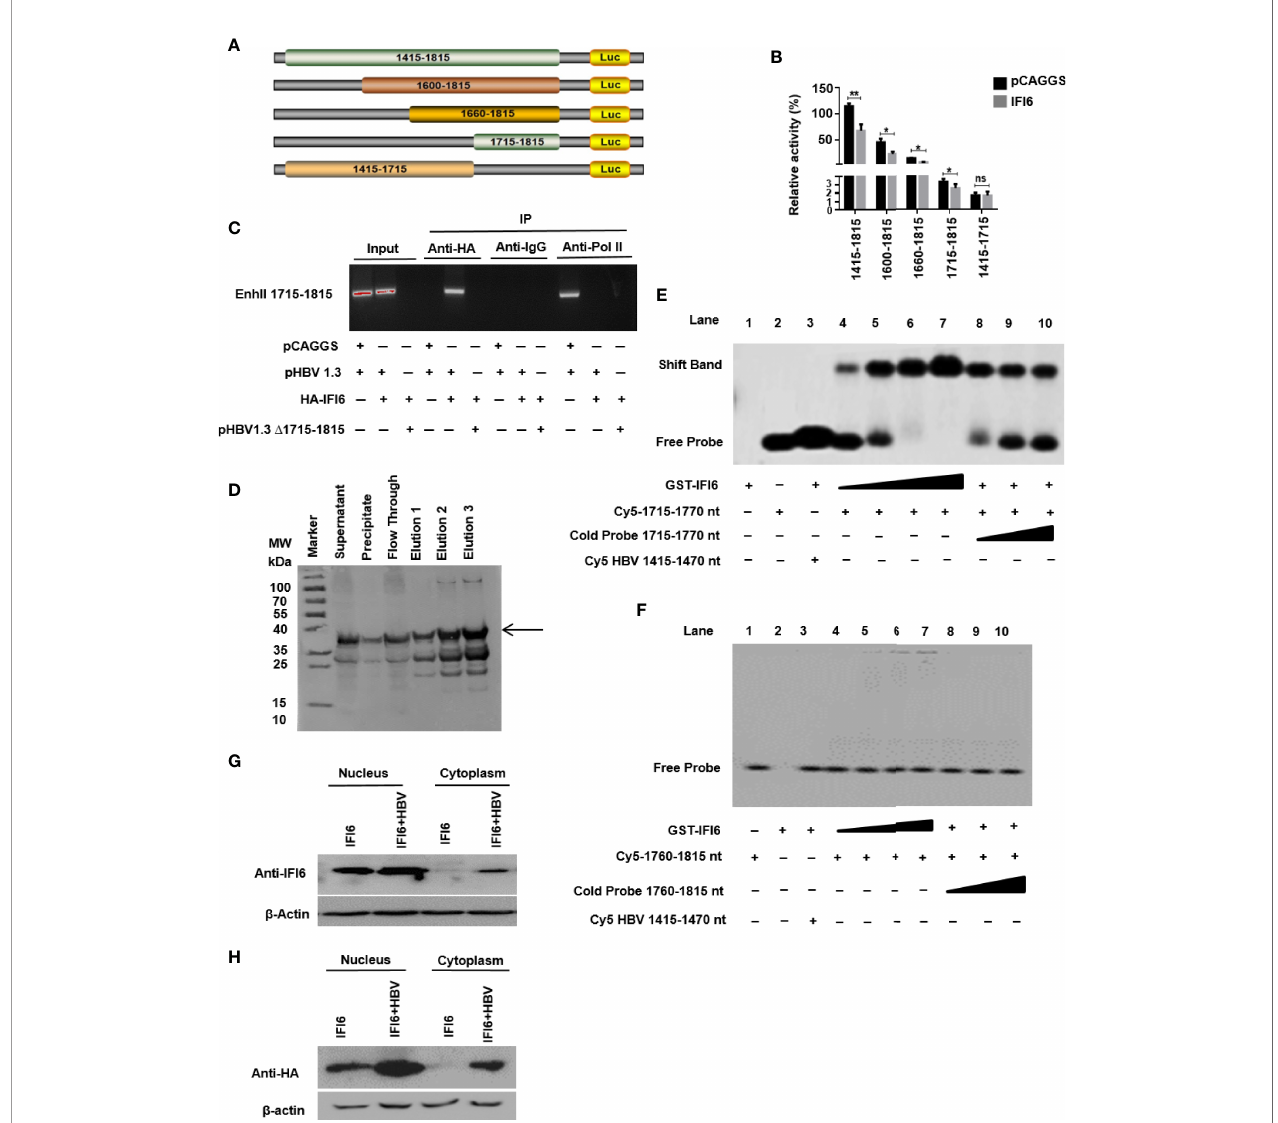
FIGURE 5 | IFI6 suppresses HBV replication by binding to 1715-1770 nt of EnhII/Cp promoter. (A) Schematic diagram of EnhII/Cp promoters and its truncated mutants. (B) The mutants were subcloned into pGL3 basic plasmid and transfected in HepG2 cells. Cells were harvested after 48 h of transfection, and Dual- luciferase activity was measured. (C) HepG2 cells were seeded in a 10 cm dish and transfected with pHBV1.3 (5 µg) with IFI6 (5 µg) or control plasmid (pCAGGS, 5 µg), after 48 hours of transfection, cells were harvested, immunoprecipitate was extracted with overnight incubation of Anti-Polymerase II, mouse IgG, and Anti- HA-Tag antibody to analyze the binding ability of EnhII 1715-1815. The protein-bound EnhII 1715-1815 DNA was extracted, ampli fi ed with PCR, and detected with agarose gel electrophoresis. (D) Expression and puri fi cation of recombinant GST-IFI6 protein were performed from E.coli . The western blot was performed to measure the size of the GST-tagged IFI6 protein. The arrow indicated the expected band size of protein, and elution 3 was used for subsequent EMSA experiments. (E) EMSA was performed to determine the speci fi c binding of IFI6 with EnhII/Cp 1715-1770 region. Lane 1, GST IFI6 protein alone, Lane 2, Cy5 labeled probe (1715-1770 nt) alone, Lane 3, Cy5 labeled probe (1715-1770 nt) incubated with non-speci fi c competitor probe (Cy5 1415-1470), Lane 4-7, Cy5 labeled probe (1715-1770 nt) incubated with different concentrations of GST IFI6 protein, Lane 8-10, a competition of Cy5 labeled probe (1715-1770 nt) with different concentrations of an unlabeled cold probe (1715-1770 nt). (F) EMSA was used to determine the binding of IFI6 with EnhII/Cp 1760-1815 region. Lane 1, Cy5 labeled probe (1760-1815) alone, Lane 2, GST IFI6 protein alone, Lane 3, Cy5 labeled probe (1760-1815 nt) incubated with non-speci fi c competitor probe (Cy5 1415-1470), Lane 4-7, Cy5 labeled probe (1760-1815 nt) incubated with different concentrations of GST IFI6 protein, Lane 8-10, a competition of Cy5 labeled probe (1760-1815 nt) with different concentrations of an unlabeled cold probe (1760-1815 nt). (G) HepG2 cells were seeded in 12 well cell culture plates and transfected after 24 hours with IFI6 (1 µg) alone or co-transfected with pHBV1.3 (0.5 µg). Cells were harvested after 48 h posttransfection. Nuclear and cytoplasmic protein was extracted and subjected to western blot. The anti-IFI6 and (H) anti-HA-tag antibodies were used to determine the protein level of IF6 and HA-tag respectively from nuclear and cytoplasmic extracted protein. The b -actin was used as a loading control. The data shown in the graph are averages of three independent experiments; the results were measured as a mean ± SD and were statistically measured. * P < 0.05, ** P < 0.01, ns, non-signi fi